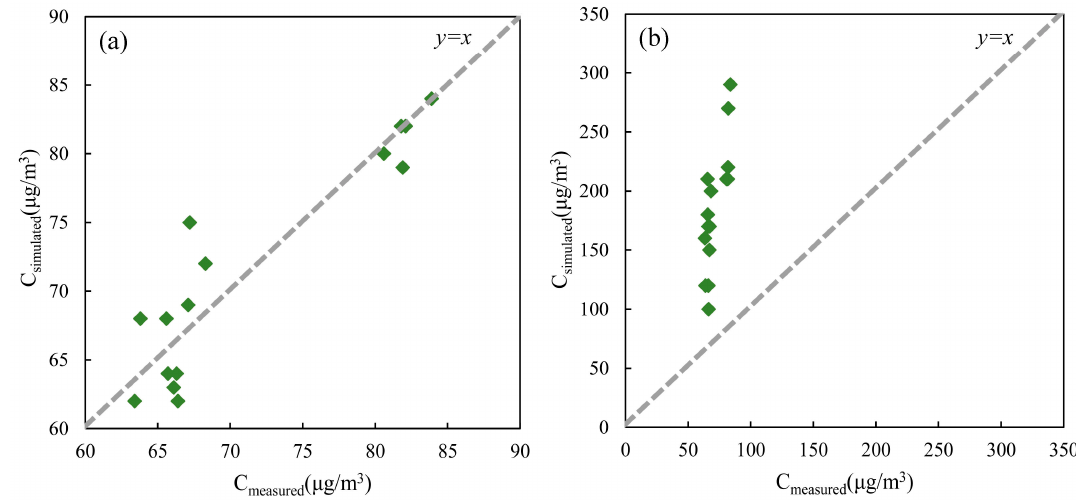
Figure 6. Comparison of OSPM-simulated and measured roadside concentrations of PM 10 ( µ g/m 3 ). ( a ) Back-calculated emission factors for different kinds of vehicles were used; ( b ) Modeled emission factor was used.